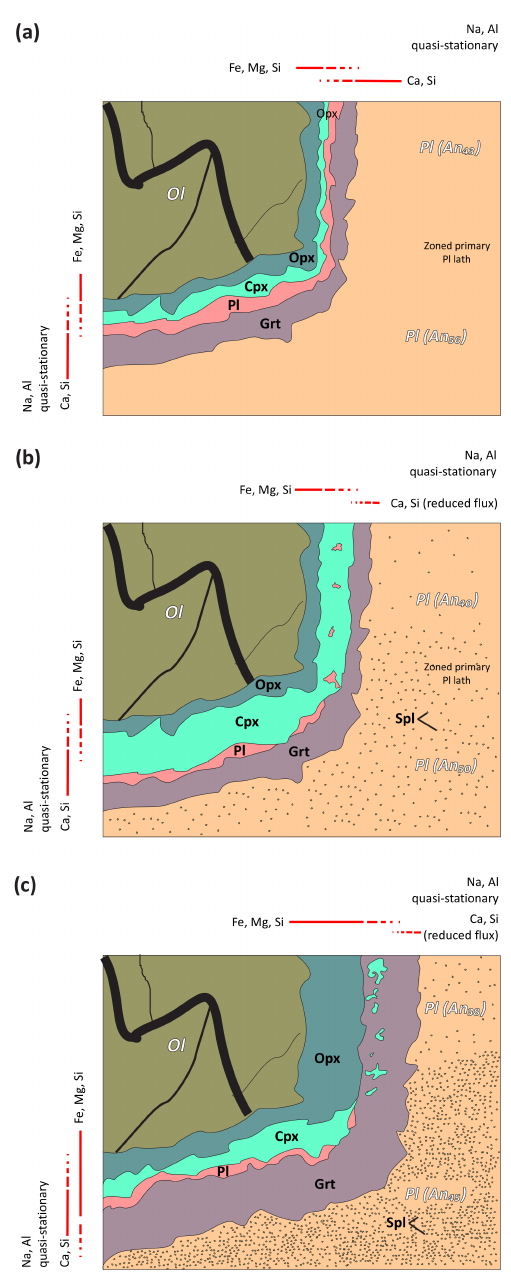
Figure 5. Multi-stage sequential layer corona layer development at constant P and T in response to waning boundary fluxes of rapidly diffusing components from the reactants into the corona in an open system (after Johnson and Carlson, 1990). (a) Initial steady-state layer configuration for an olivine–plagioclase corona. (b) Depletion of Ca and Si in the reactants leads to the consumption of plagioclase and then (c) clinopyroxene in transient states. The system gradually evolves toward a new steady state. Cannibalization of corona pla- gioclase and clinopyroxene is more enhanced where the original reactant is Ca-poor (top right, An 38 )